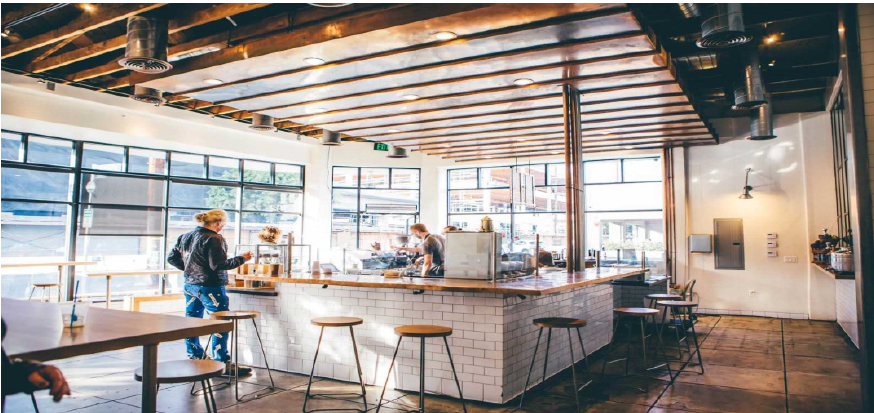
Figure 19. Blue Bottle design utilizing lighting effects through large windows [70].